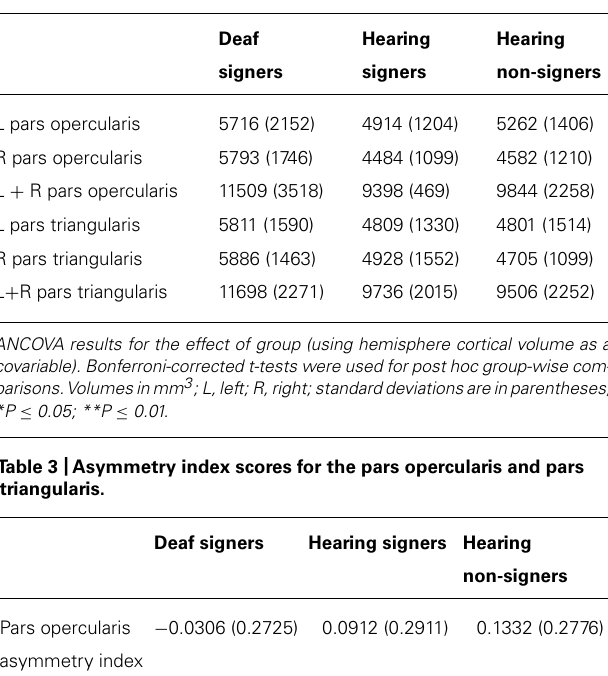
Table 2 | Cortical volumes of pars opercularis, pars triangularis, and combined pars triangularis and opercularis.